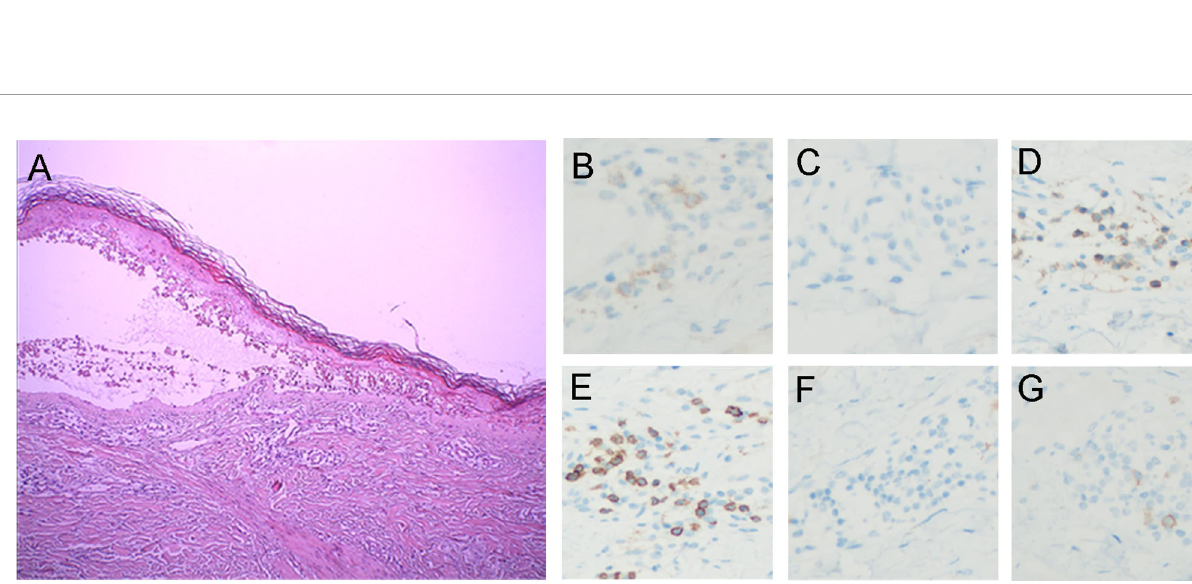
FIGURE 2 | Histopathologic and immunohistochemical fi ndings. (A) Histopathologic analysis demonstrated (1) epidermal hyperkeratosis with intraepidermal edema and blister formation (2), basal and suprabasal apoptotic keratinocytes with focal con fl uent apoptosis, and (3) moderate perivascular lymphocytic in fi ltration in the super fi cial dermis. Immunostaining shows (B) PD-1-positive lymphocytes (anti-PD-1, ×200) and (C) no PD-L1-positive cells (anti-PD-L1, ×200). Immunostaining revealed (D) CD4+ (anti-CD4, ×200) and (E) CD8+ T cell in fi ltration (anti-CD8, ×200). Immunohistochemistry con fi rmed the absence of (F) B cells (anti-CD20, ×200) and (G) NK cells (anti-CD56, ×200).